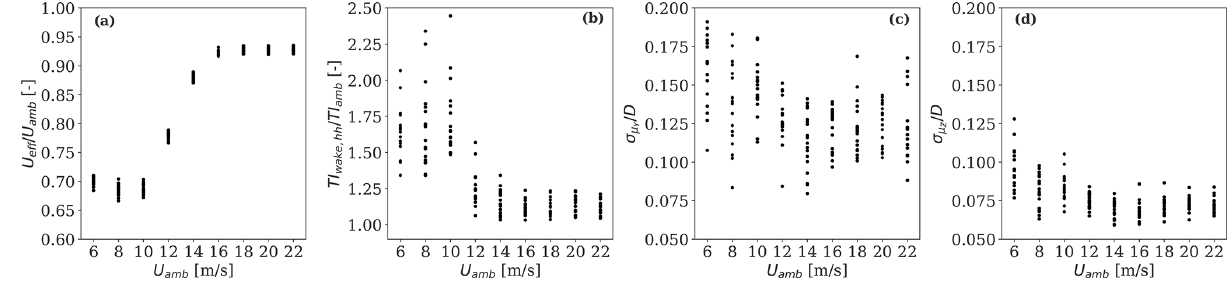
Figure 8. Scatter plots of the 10min wake field characteristics resulting from the 162 simulations used as target in the load analysis. The /D is a measure of the amplitude of wake parameter TI wake,hh refers to the turbulence intensity measured at hub height in the wake; σ µ y /D refers to the vertical displacement of the wake (see text for details). meandering in the lateral direction, and σ µ z